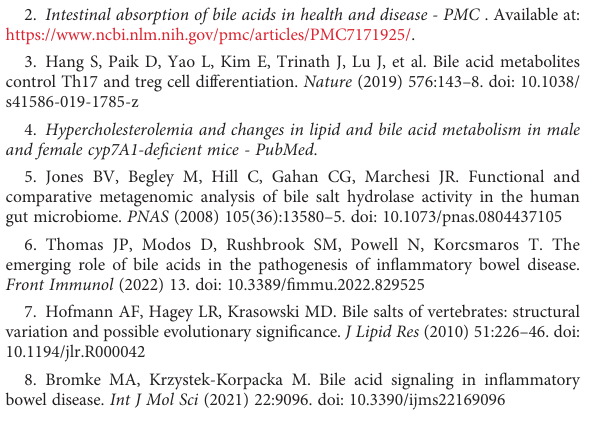
Figure. NC, SC, PKD, SS, RKG and WAA edited and